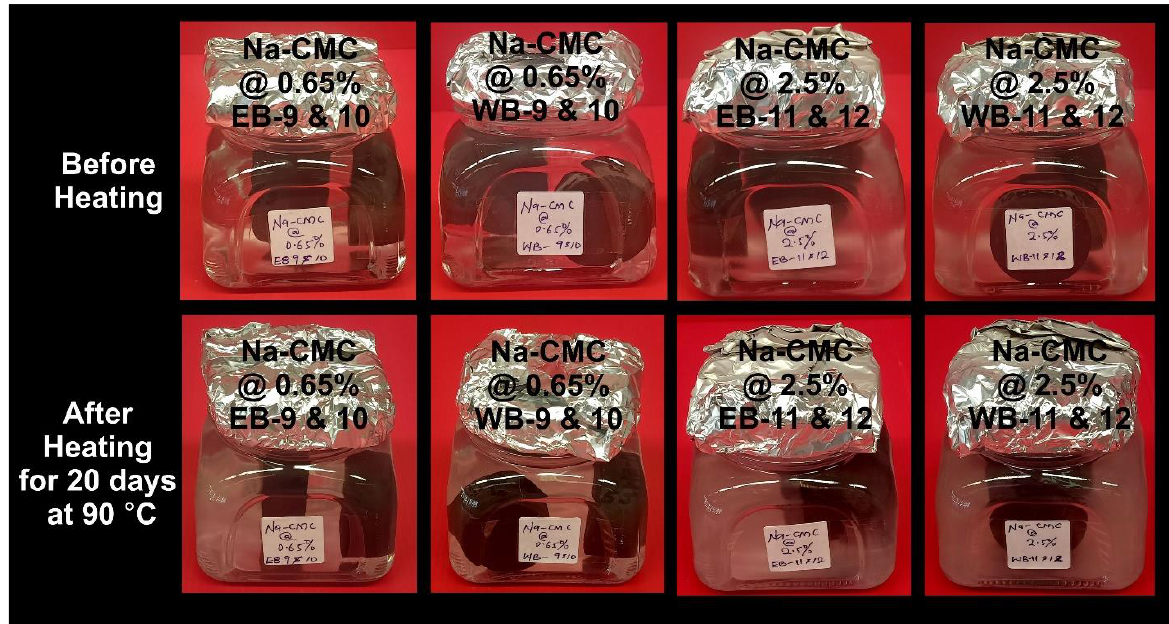
Figure 13. Borosilicate glass containers housing paired samples exposed to LFF at 90 °C for a period of 20 days.